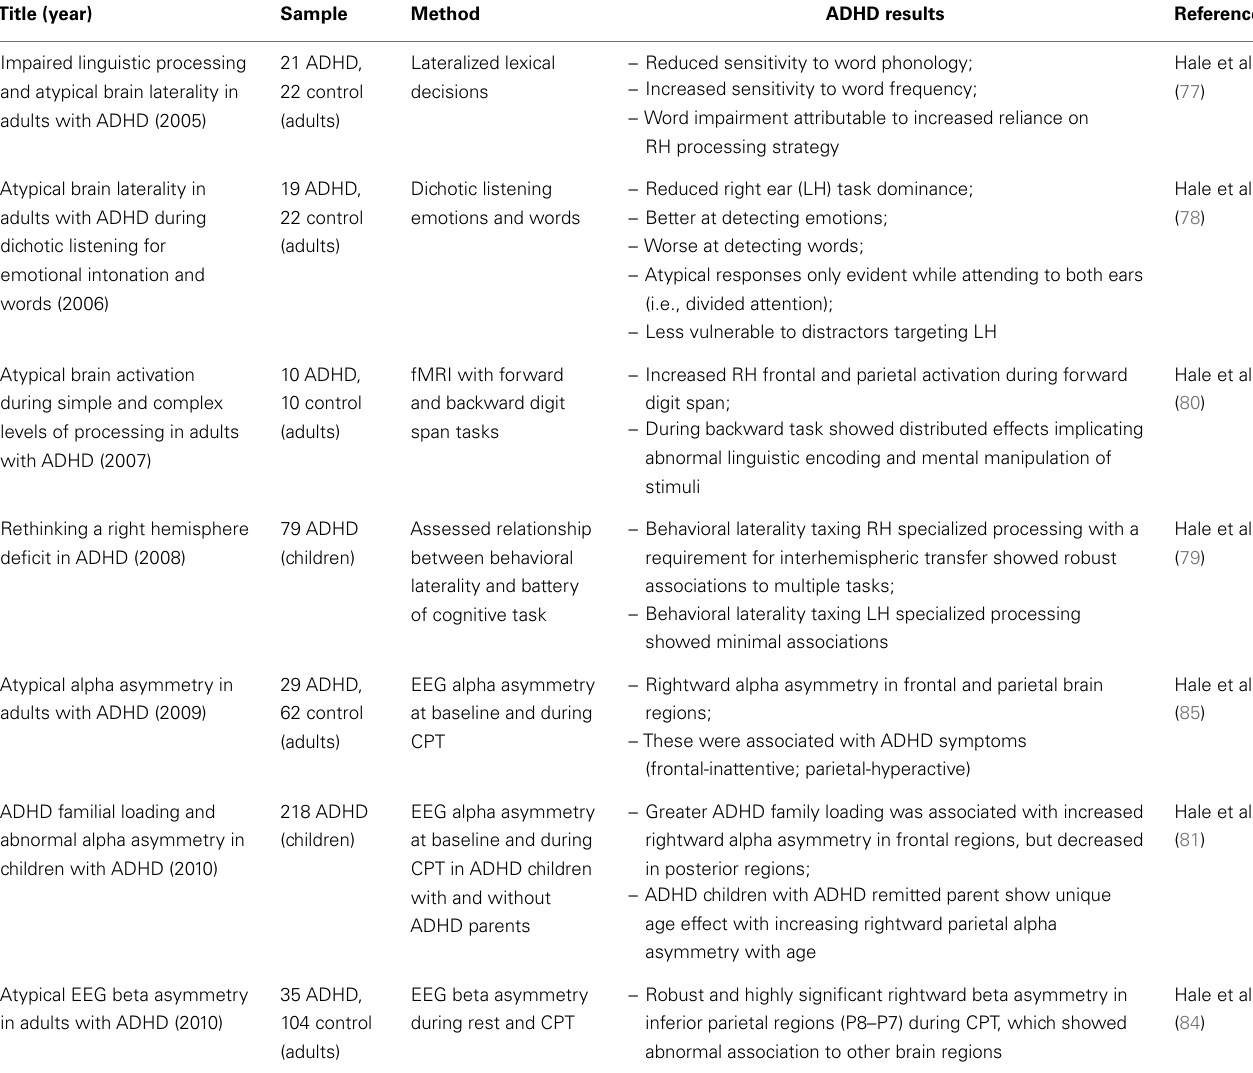
Table 2 | Summary of our previous studies of RH biased processing inADHD